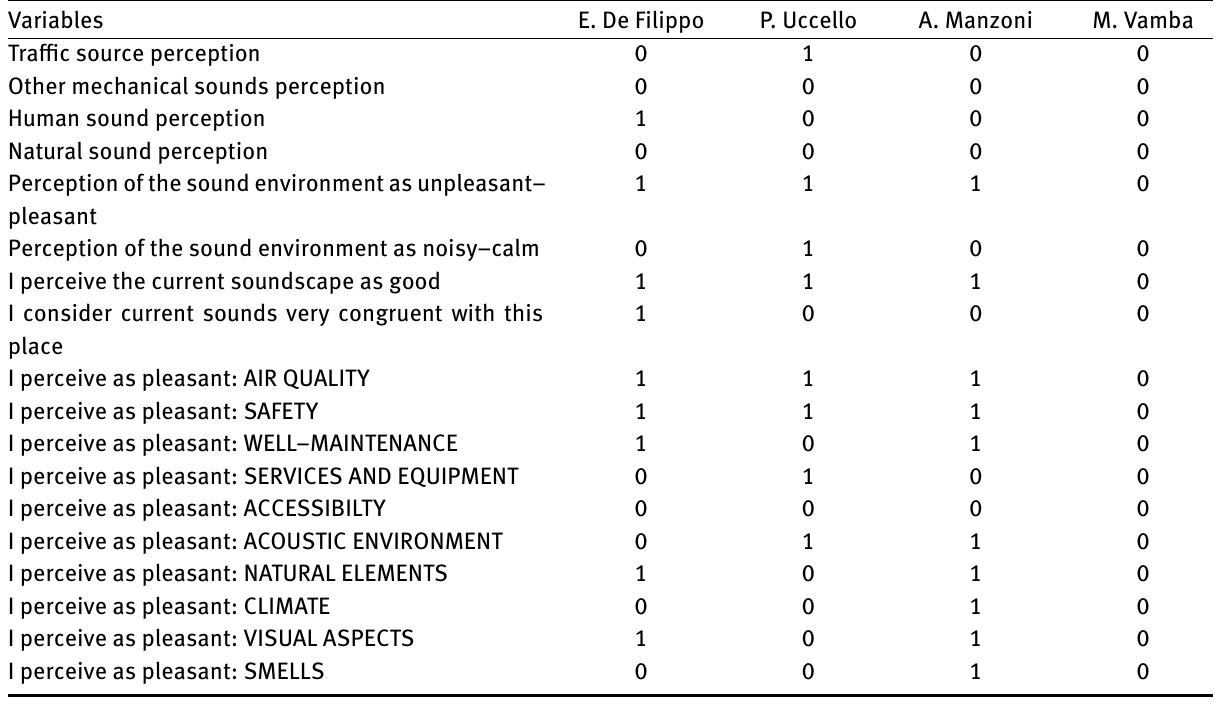
Table 5: Results obtained after the use of nonparametric tests (0 = equally–distributed parameter; 1 = unequally–distributed parameter). Variables